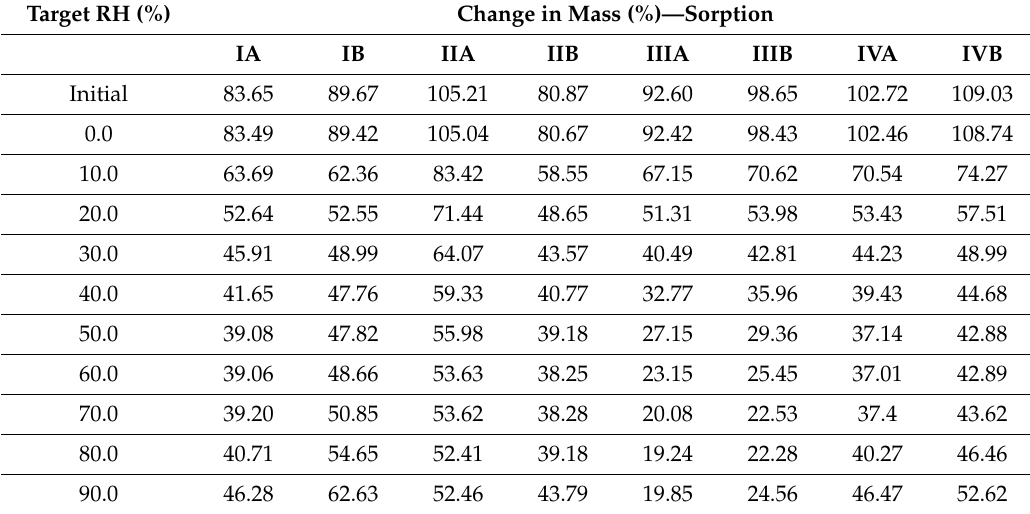
Figure 6. Graphical illustrations of moisture sorption and desorption kinetics at constant temperature of 25 °C, showing change in mass, DM (red) and % relative humidity, RH (blue) plotted against time/min, DT, of all model creams. Table 6. Target relative humidity (increasing steps) and % change in sample mass through moisture content uptake (sorption). Target RH (%) Change in Mass